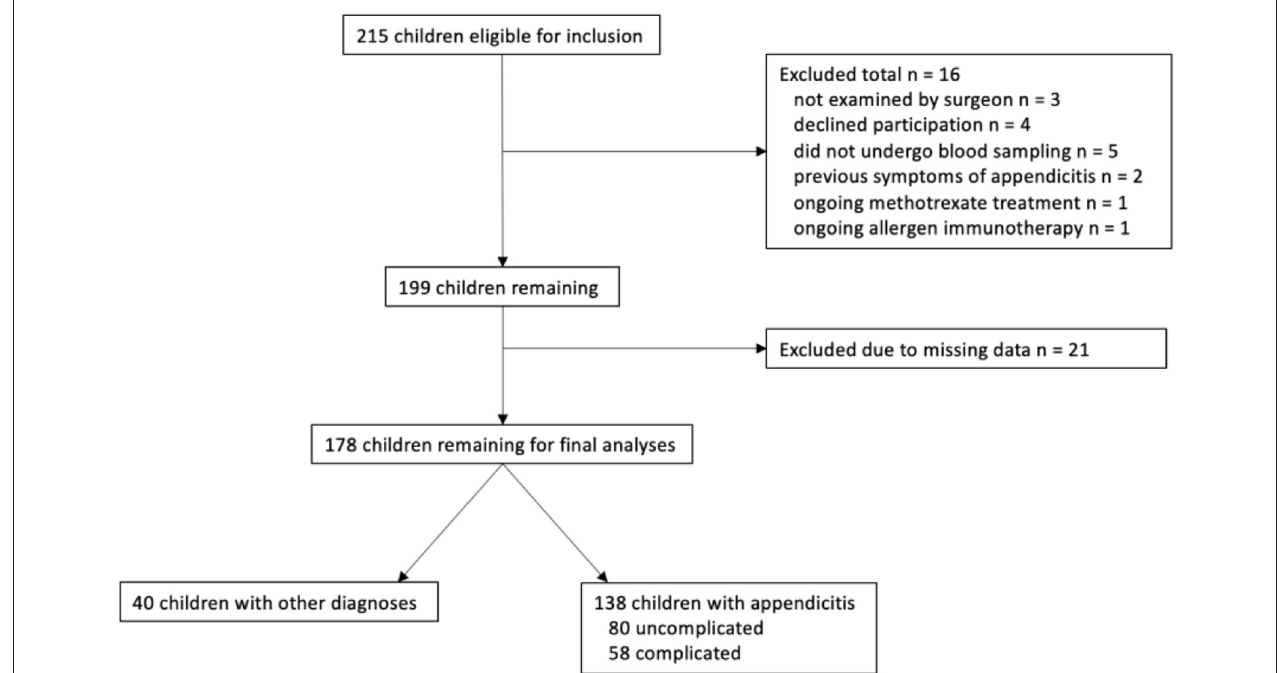
FIGURE 1 | The inclusion and exclusion of 215 children with suspected